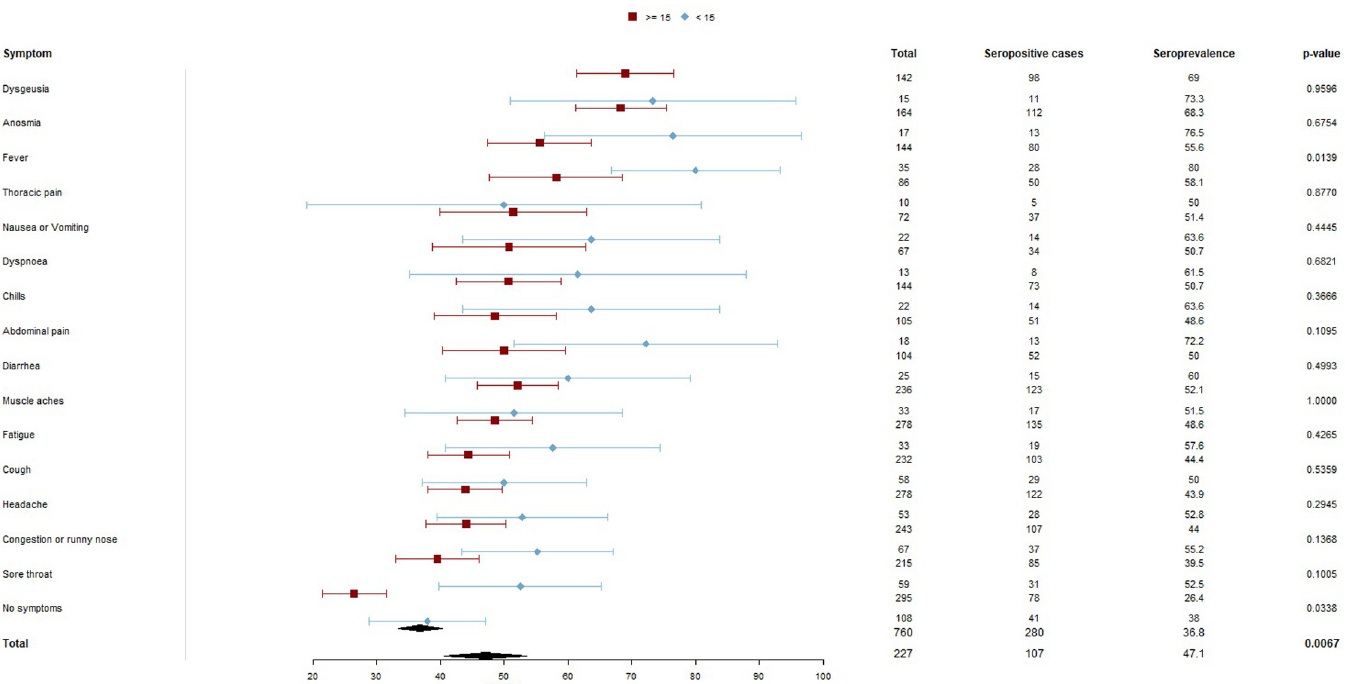
Fig 5. Forest diagram of SARS-CoV-2 seroprevalence according to reported symptoms in two age groups (under 15 and 15 and older). Puerto Madryn-Chubut, 2021. N = 987.